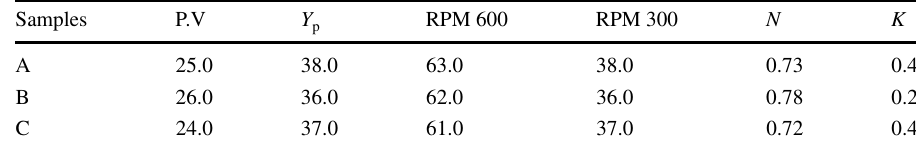
Table 13 Power law index for